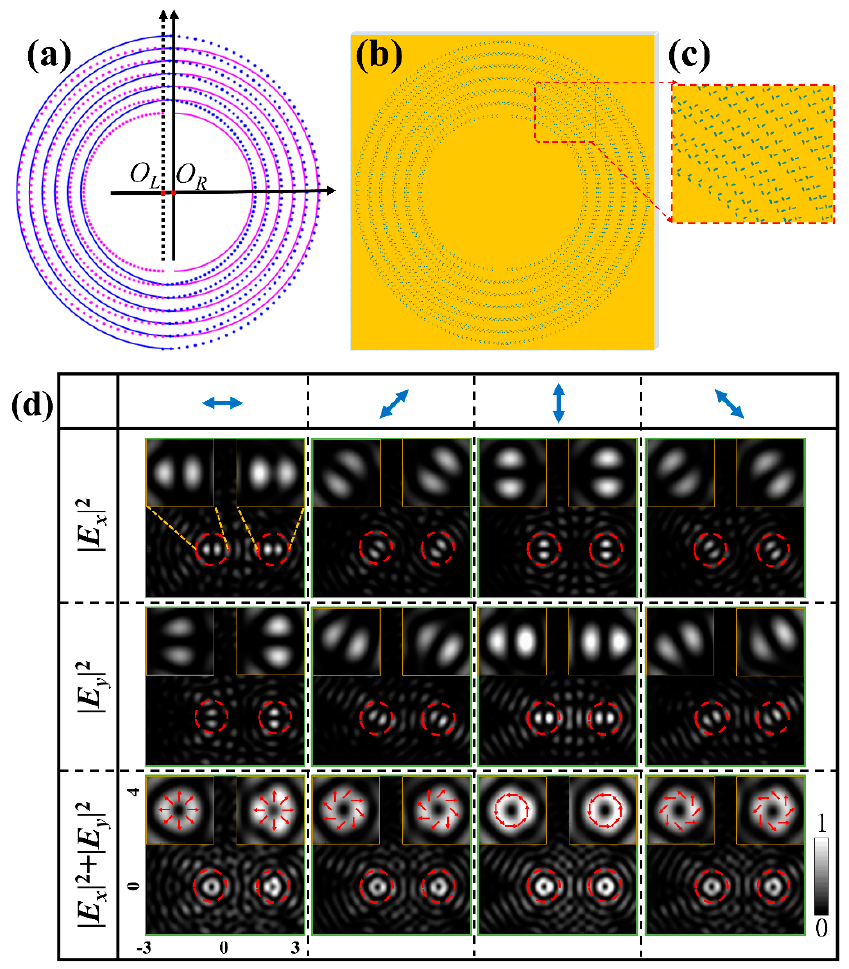
Figure 4. ( a ) Plot of the CSRs. ( b ) The metasurface sample. ( c ) The enlarged view. ( d ) Intensity patterns of the different dual VBs. From left to right columns are dual VBs of the radial, 135 ◦ -slanted, azimuthal, and 45 ◦ -slanted polarizations produced by sample under the illumination of horizontal, 45 ◦ , vertical, and 135 ◦ linearly polarized light, respectively. From top to bottom rows are the intensity patterns of I = | E x | 2 , | E y | 2 and | E x | 2 + | E y | 2 . The insets are the enlarged views. The overlaid arrows show the schematic polarization states. The double arrows represent the linear polarization of illumination light.